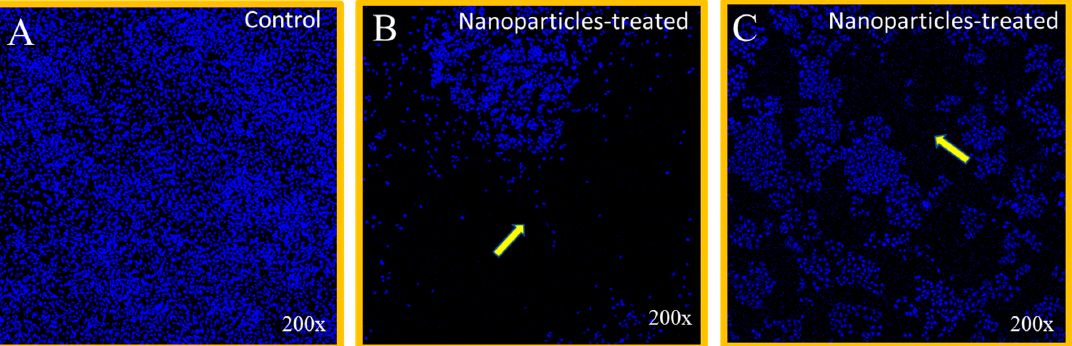
Figure 4. Cancer cells stained with 4 ′ ,6-diamidino-2-phenylindole (DAPI). HCT-116 cells treated with Mn 0.5 Zn 0.5 Sm x Eu x Fe 1.8 − 2x O 4 (0.01 ≤ x ≤ 0.05) NPs for 48 h. ( A ) is control without treatment, ( B ) treated with Mn 0.5 Zn 0.5 Sm x Eu x Fe 1.8 − 2x O 4 NPs for x = 0.01 concentration (2.35 µg/mL), and ( C ) treated